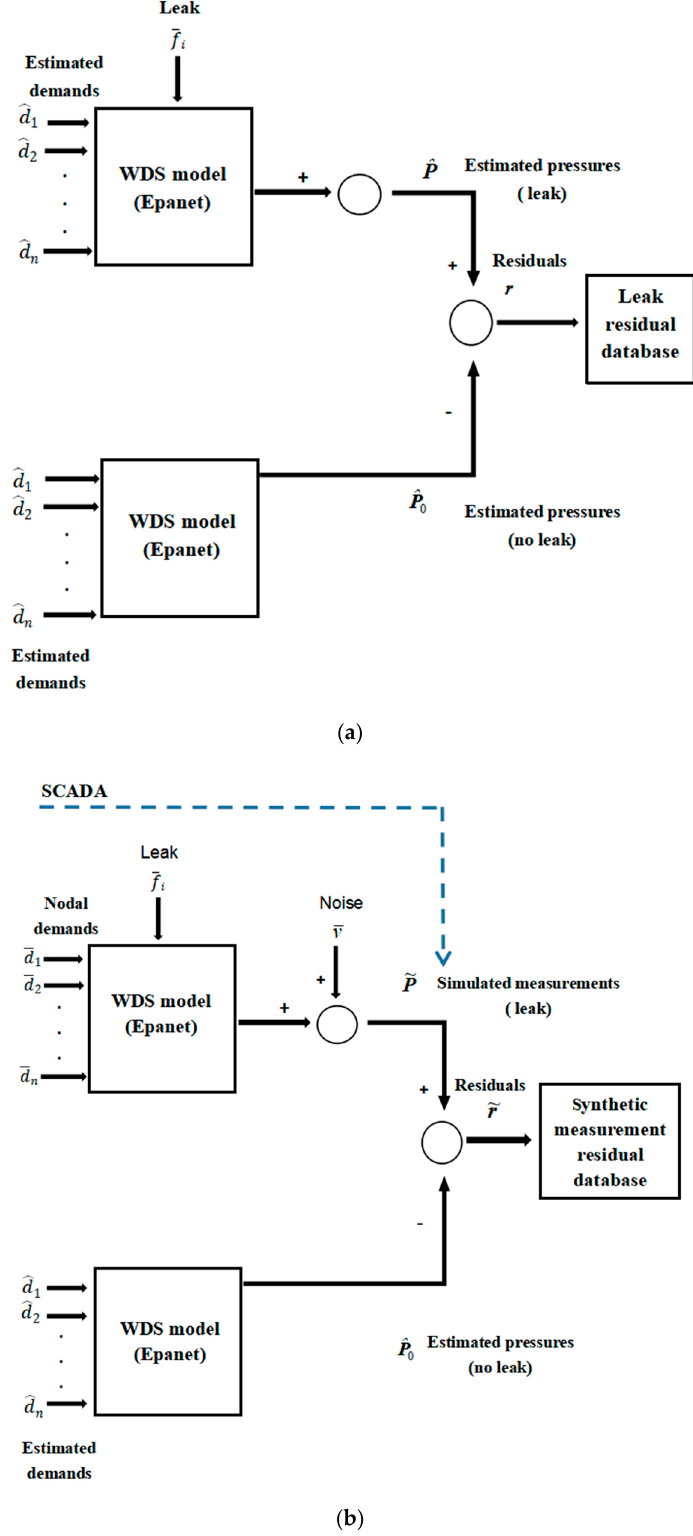
Figure 3. Data generation scheme: ( a ) predicted pressure residual database of the leak scenarios; ( b ) synthetic measurement pressure residual database. ( b ) synthetic measurement pressure residual